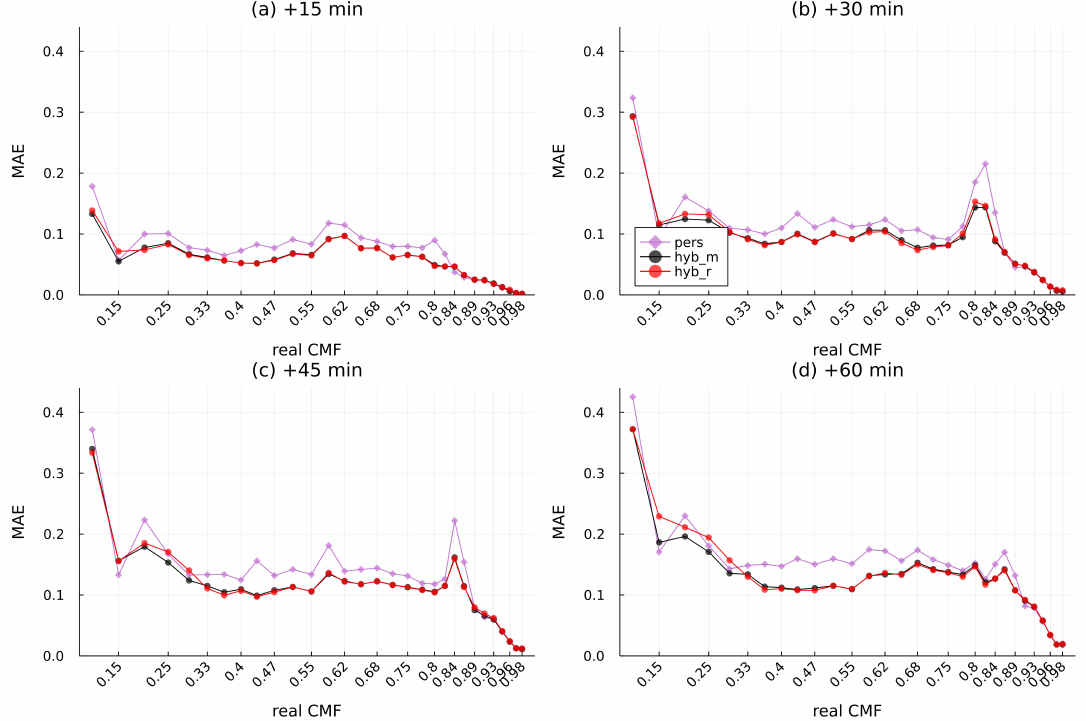
Figure A6. MAE for each CMF class for ( a ) 15 min, ( b ) 30 min, ( c ) 45 min, and ( d ) 60 min ahead in 2020 for